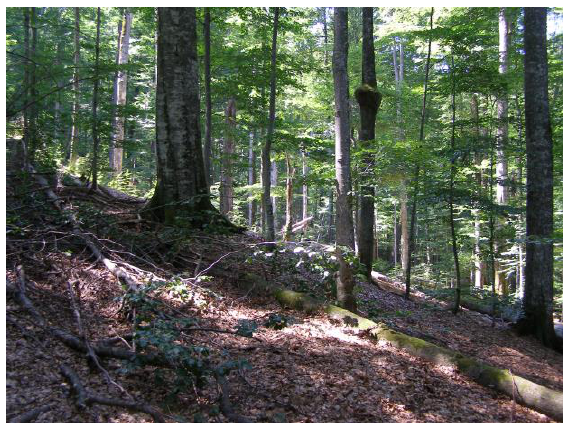
Fig. 2. Carpathian beech forest in Synevyr National Nature Park (photo by P.M.